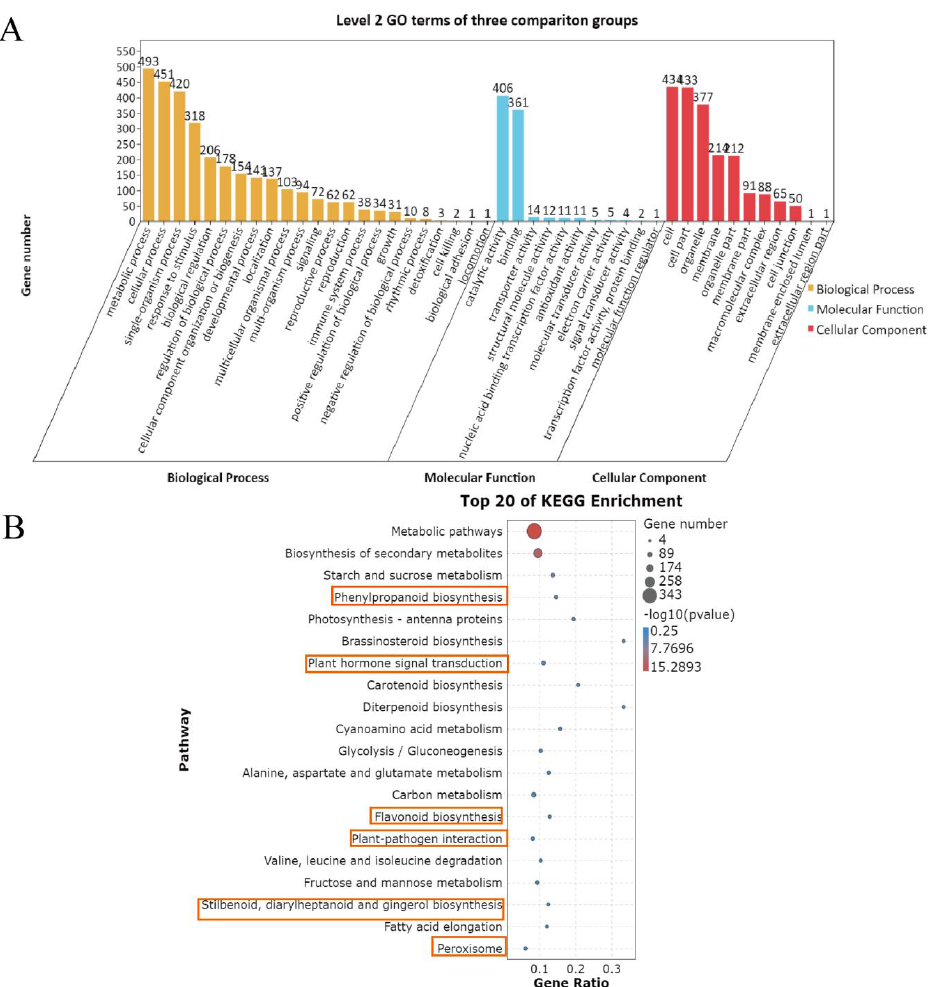
Figure 3. Transcriptomic profiles of mango fruit during storage at 25 °C. ( A ) GO functional classification of the DEGs. ( B ) Significant enrichment analysis of KEGG of the DEGs. Six pathways that are associated with disease resistance are highlighted in the orange box.